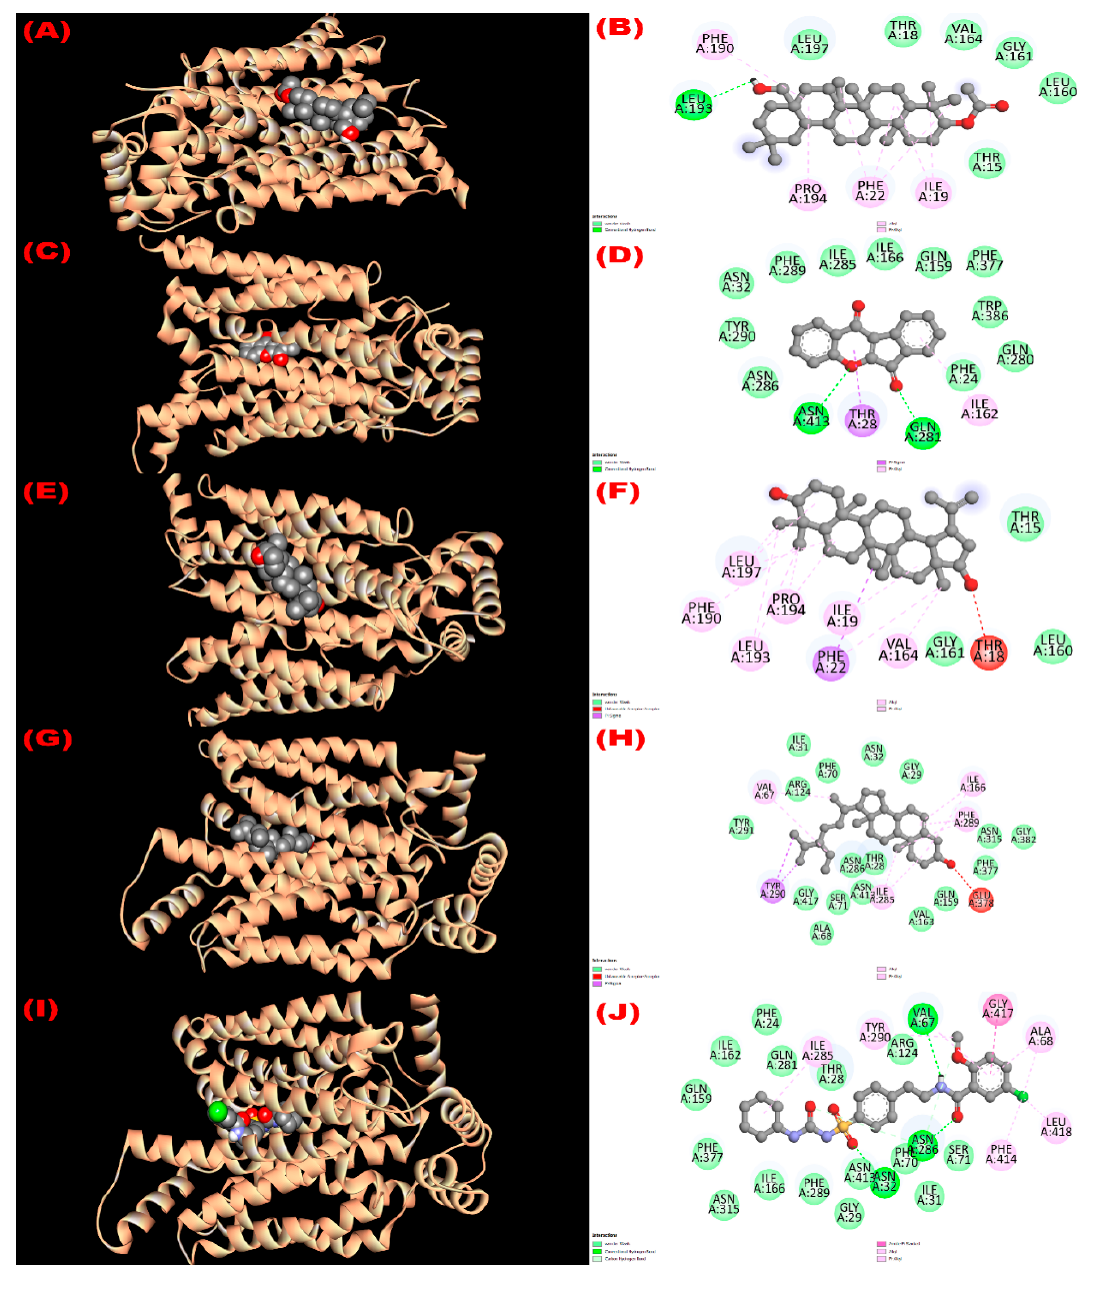
Figure 5. The 3D and 2D view of molecular interactions of the isolated compounds with the glucose transporter 3 (GLUT 3) (PDB ID: 4ZWB) revealing the hypoglycemic activity. (( A , B ), ( C , D ), ( E , F ), ( G , H ), ( I , J ) sketched the pictorial view of molecular interactions of compounds ( 1–4 ) 3 β -acetyloxy-olean-12-en-28-ol, wrightiadione, 22 β -hydroxylupeol, β -sitosterol, and the standard glibenclamide,